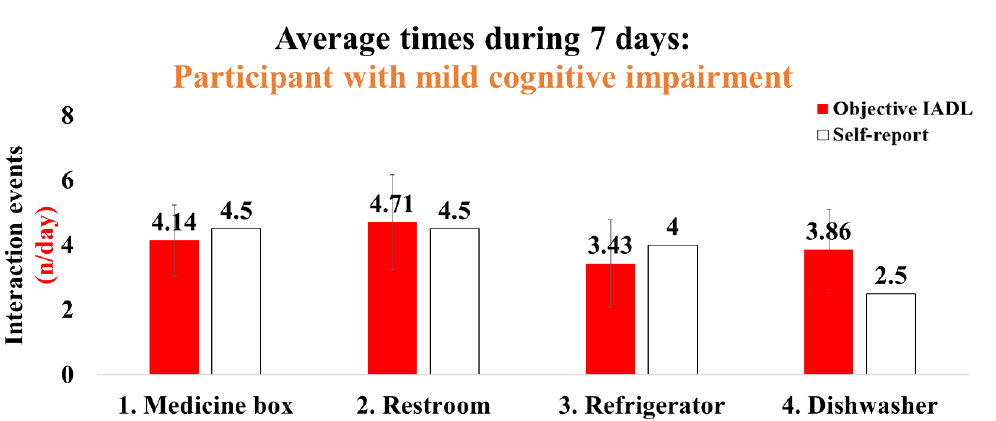
Figure 10. Results of the interaction times for IADLs in the participant with mild cognitive impair- ment: the objective IADL values provide mean and standard errors for 7 days.